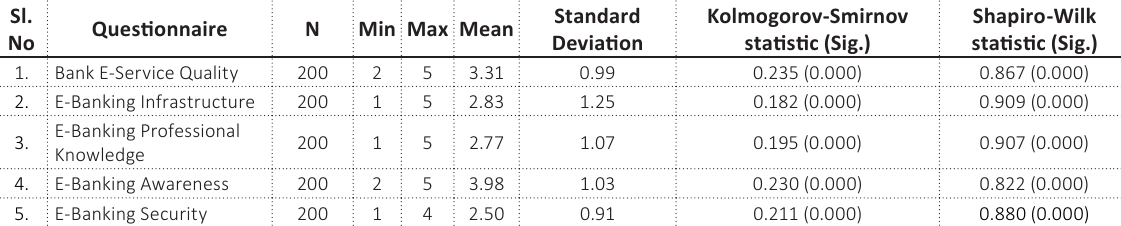
Table 1. Descriptive statistics and normality test Sl.